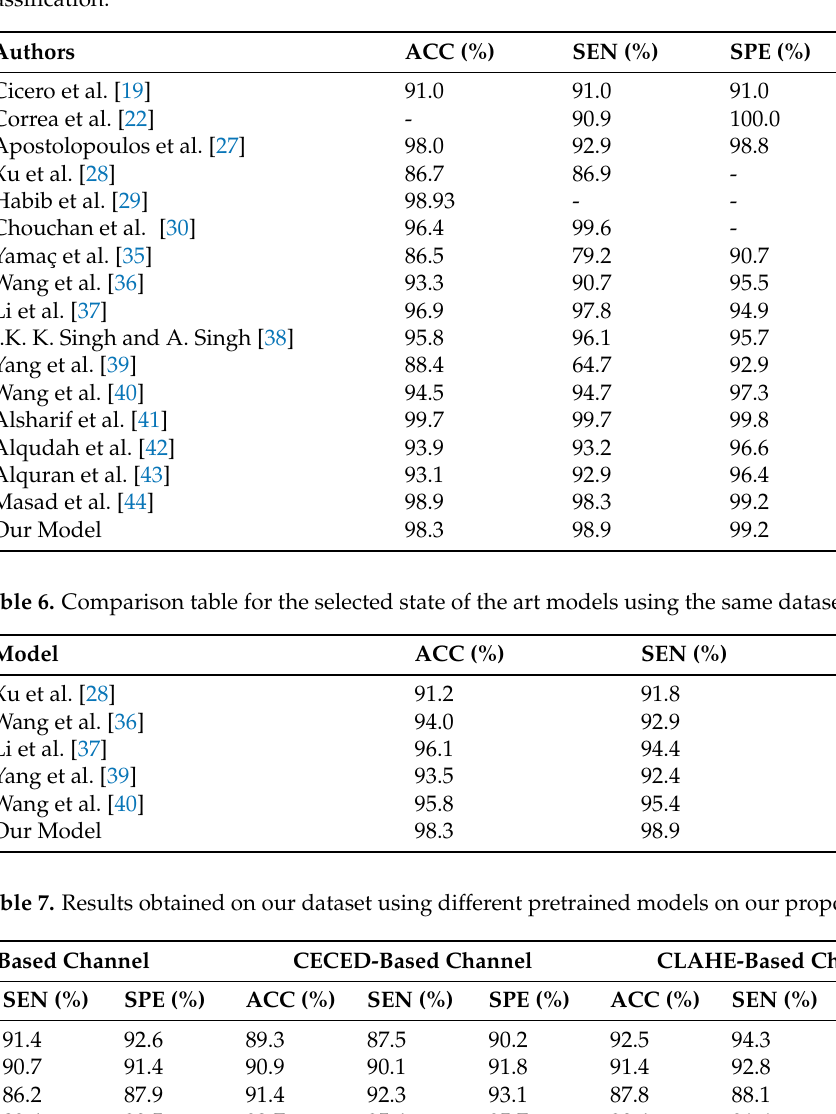
Table 5. Result comparison of our proposed model with state-of-the-art methods for pneumonia classification.